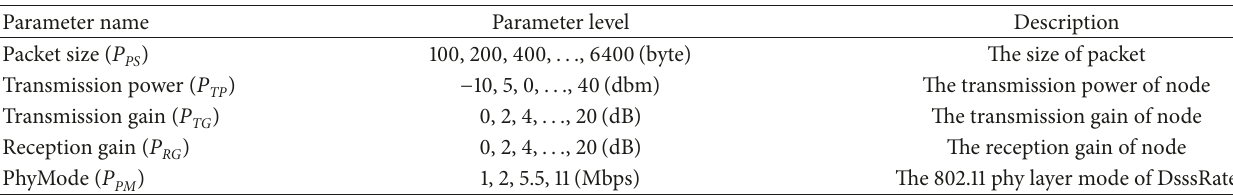
Figure 10: Realization of the object model from the trained feed-forward neural network. Table 2: Network system parameters and their